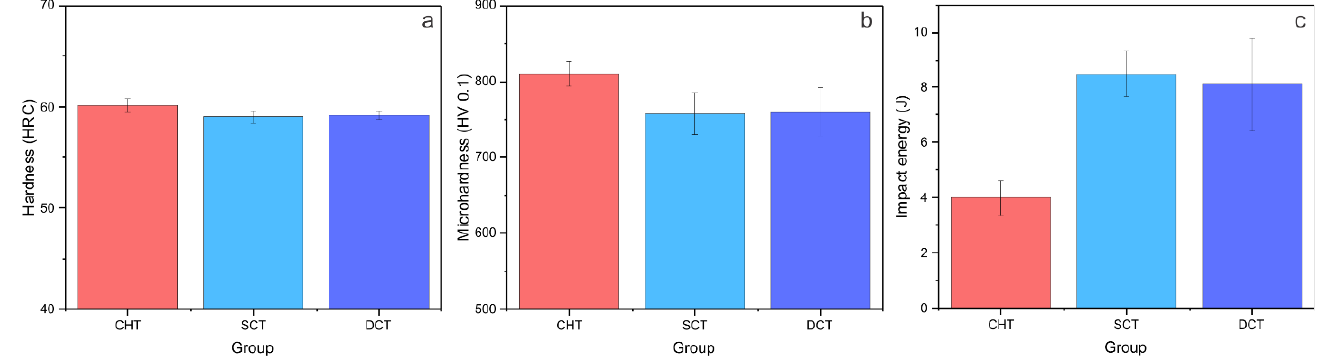
Figure 6. Tested mechanical properties: ( a ) hardness in HRC, ( b ) microhardness in HV 0.1 and ( c ) impact toughness in J.